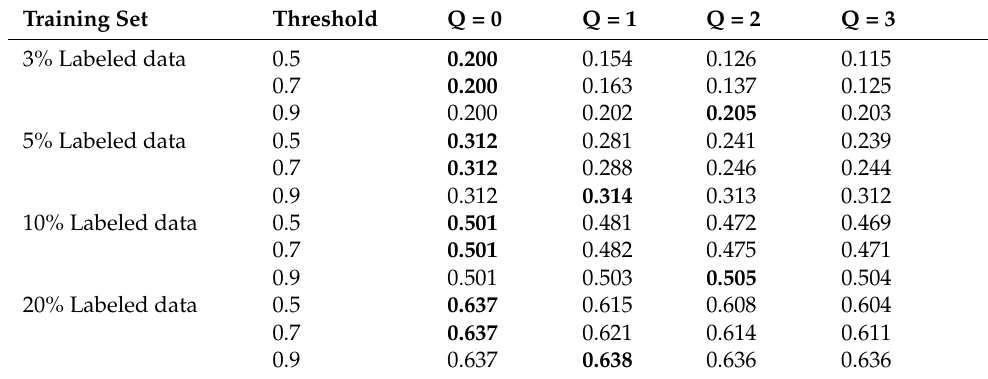
Table 4. Investigation of the proportions of labelled data, the thresholds, and the rounds. Training Set